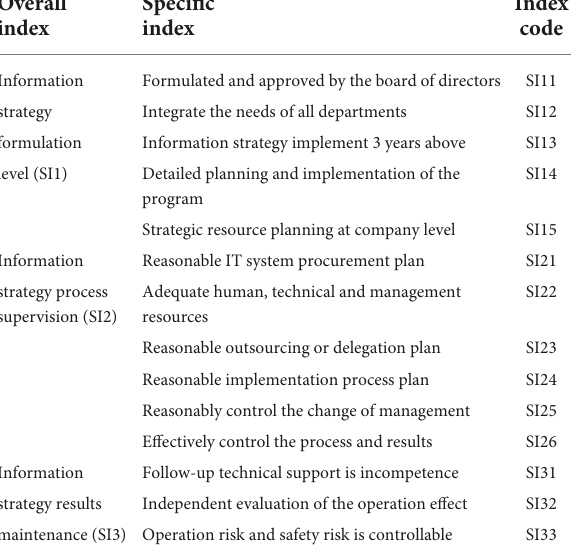
TABLE 1 Information strategy evaluation